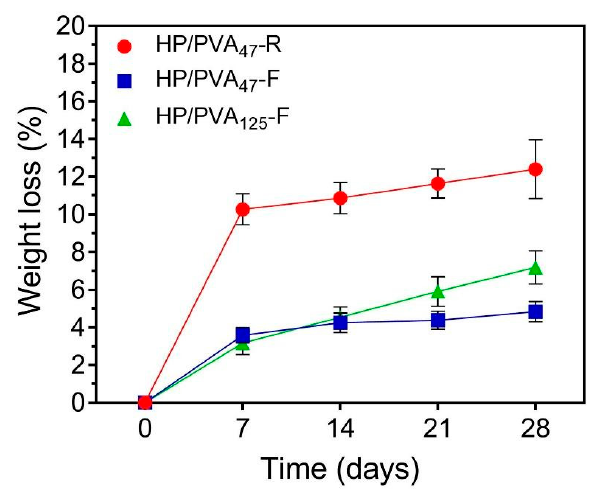
Figure 5. Weight loss profiles of HP/PVA composite hydrogels in PBS at 37 °C.